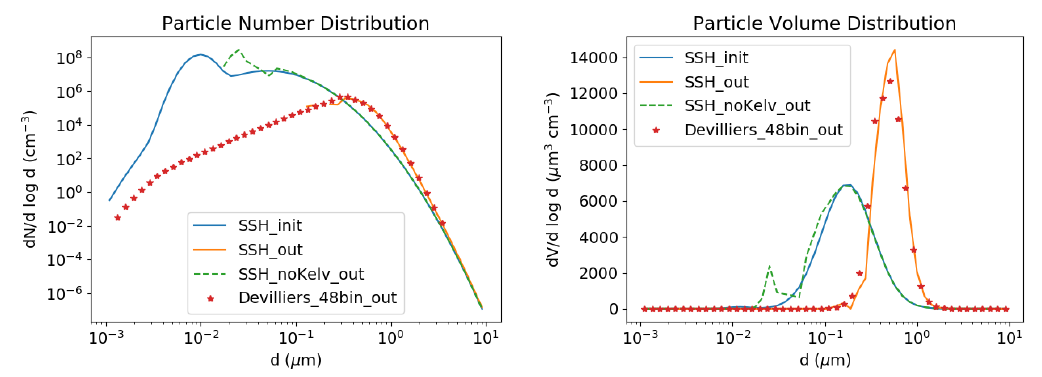
Figure 5. Kelvin test case. Number ( left ) and volume ( right ) concentrations. The initial concentrations are in blue, those simulated by SSH-aerosol are in orange (with Kelvin effect) and in dashed green (without Kelvin effect), and those simulated by Devilliers et al. [22] with 48 size sections are displayed with red